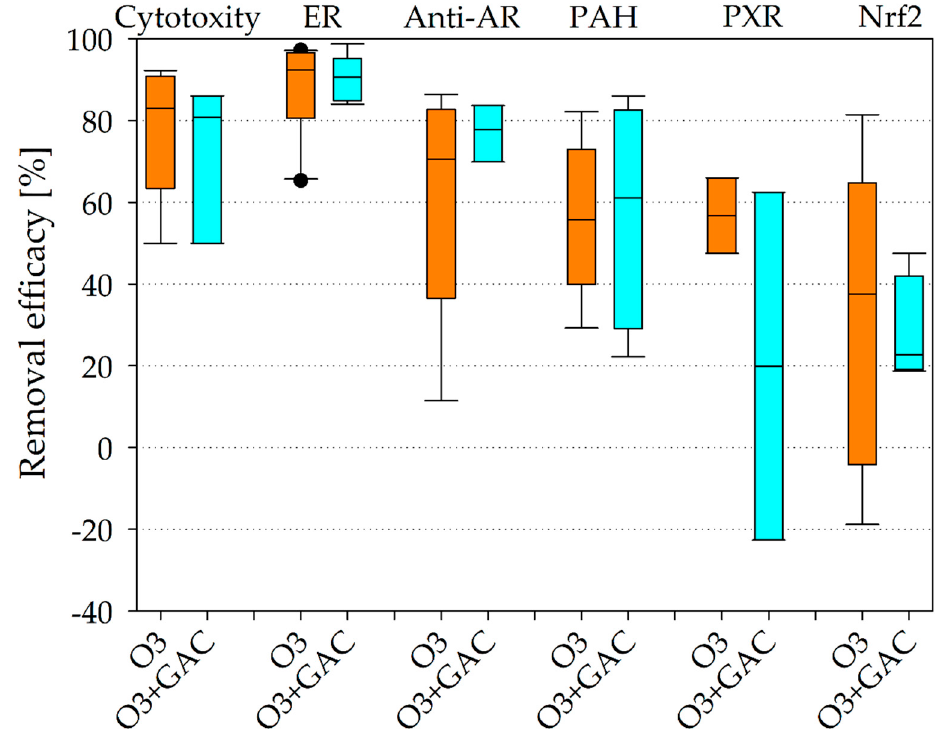
Figure 4. Boxplots showing the range of removal for the investigated MOA along the multibarrier treatment system over the one-year monitoring.